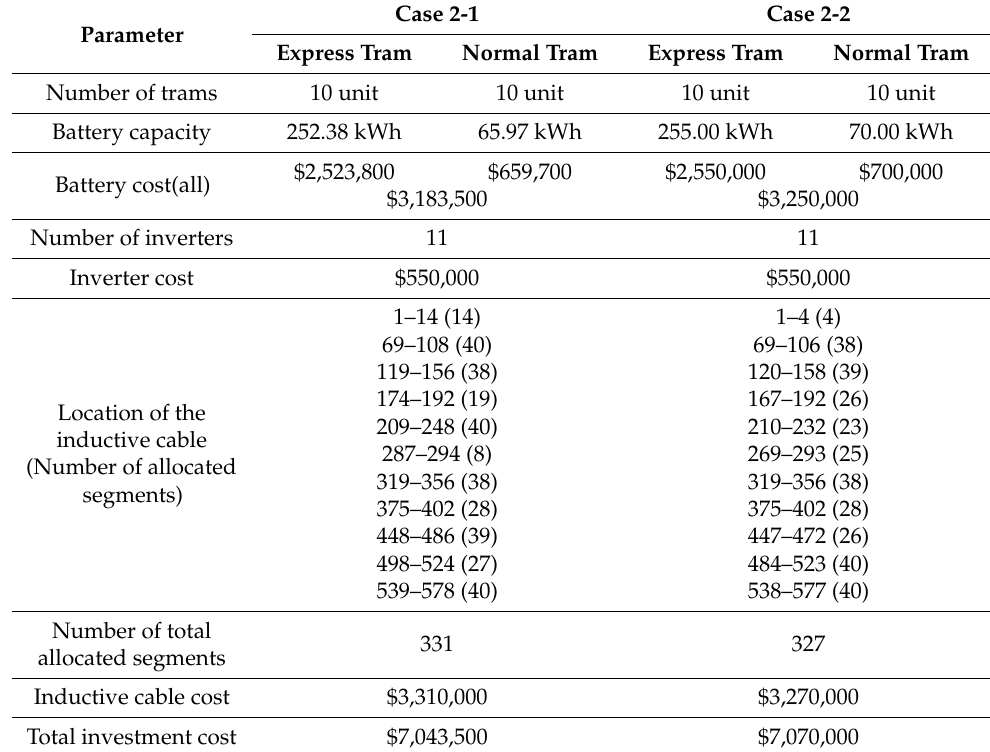
Table 5. Results of the computational experiments (Case